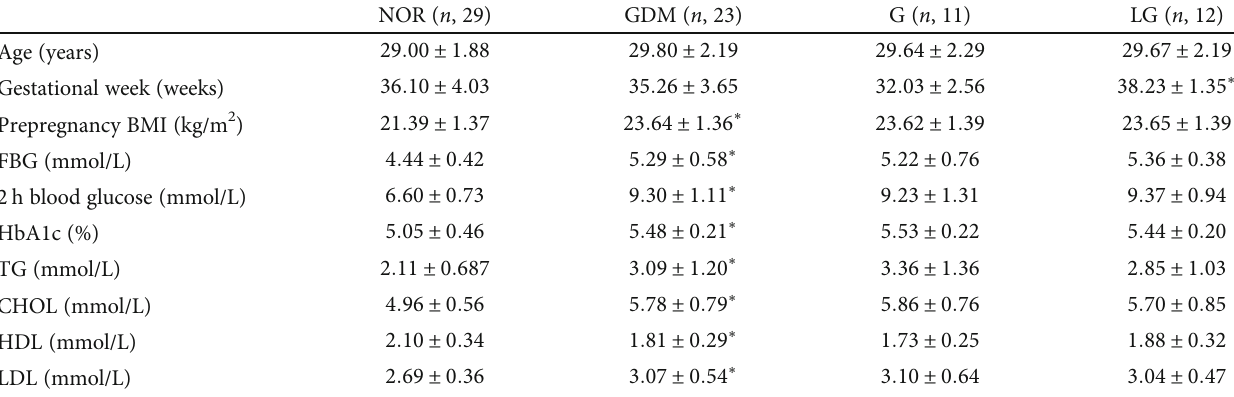
Table 1: Comparison of general conditions and biochemical indicators between the two groups of pregnant women ( x ± s ). NOR ( n ,